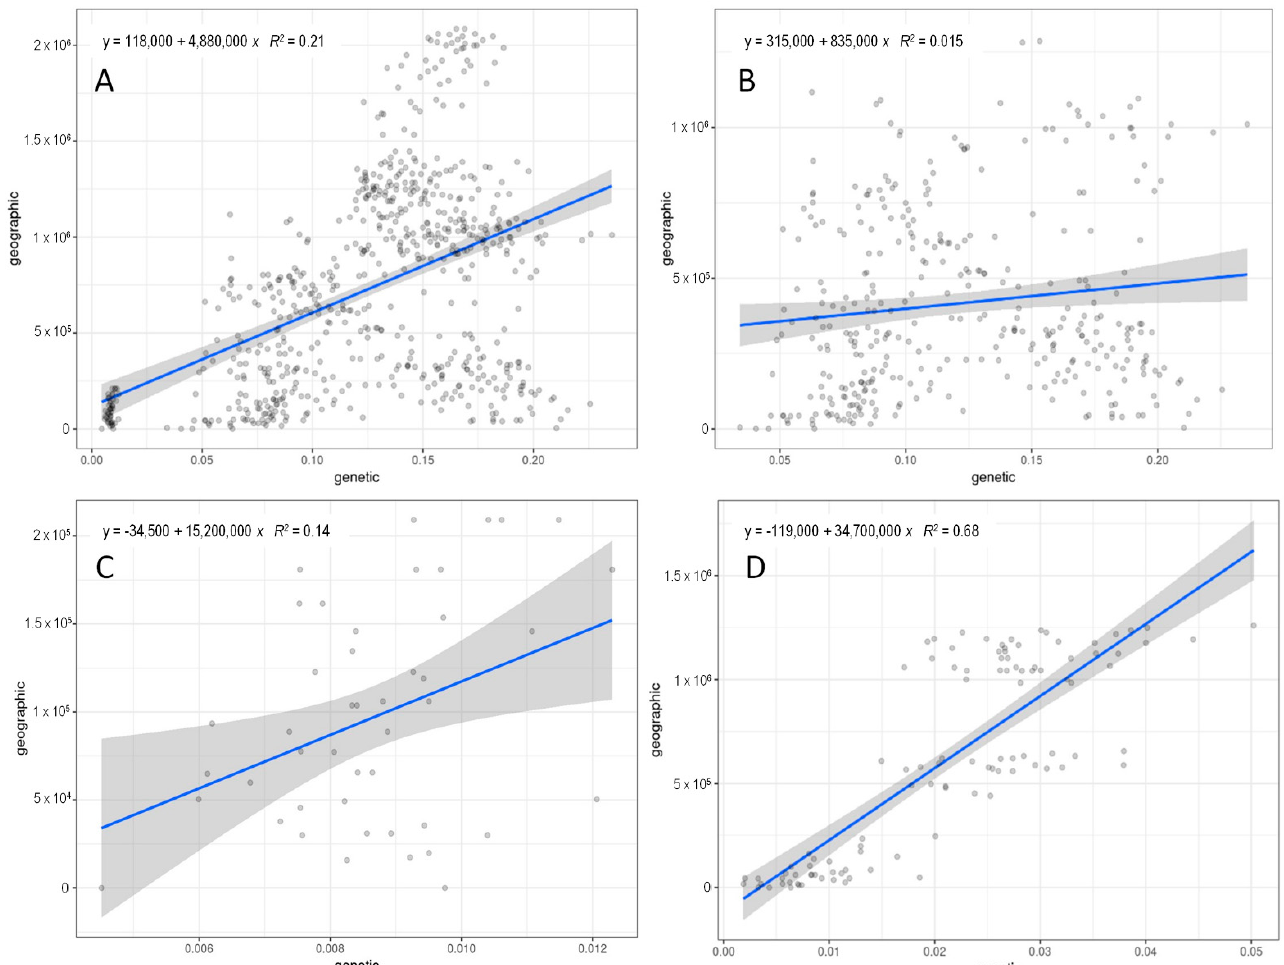
Figure 3. Geographical distances (m) versus genetic distance among locations for: ( A ) the Centaurea aspera individuals, ( B ) C. aspera diploid individuals (ssp. aspera , ssp. pseudosphaerocephala , ssp. stenophylla ), ( C ) C. aspera tetraploid individuals (ssp. gentilii ), and ( D ) tetraploid C. seridis individuals. The regression is represented by a blue line. The ribbon shows the 0.95 confidence interval.